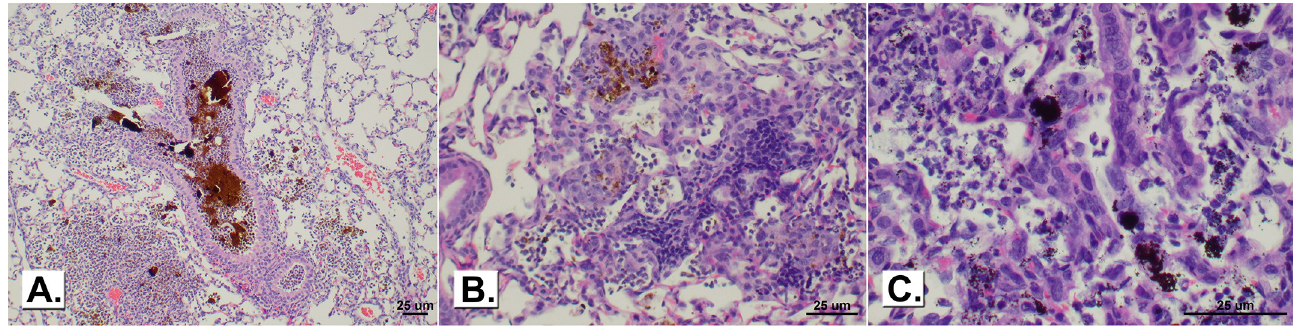
Fig 7. Exudate and brown material in the bronchial lumen of a mouse exposed to GMAW-SS fume and sacrificed 1 day post-exposure (panel A; 10x magnification). Mononuclear cell infiltrate of alveolar wall in a mouse exposed to GMAW-SS fume (panel B; 20x magnification) or low-dose Fe 2 O 3 (panel C; 40x magnification) and sacrificed 7 days